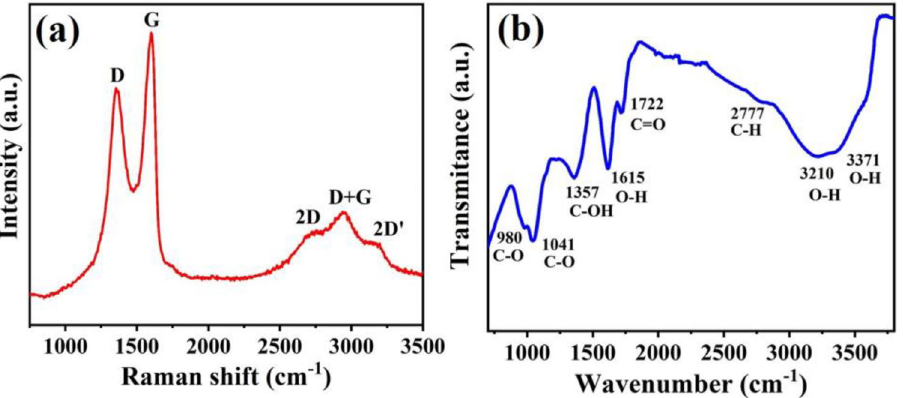
Figure 4. Graphene oxide characterizations, ( a ) Raman spectra, and ( b ) FT-IR analysis.